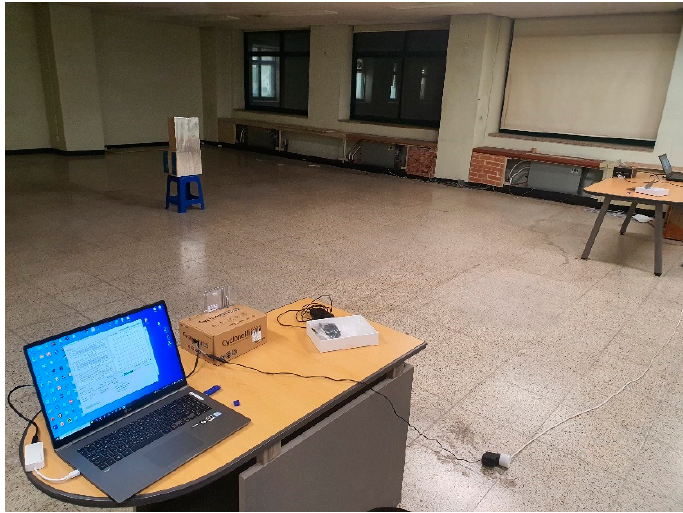
Figure 15. Actual measurement environment.